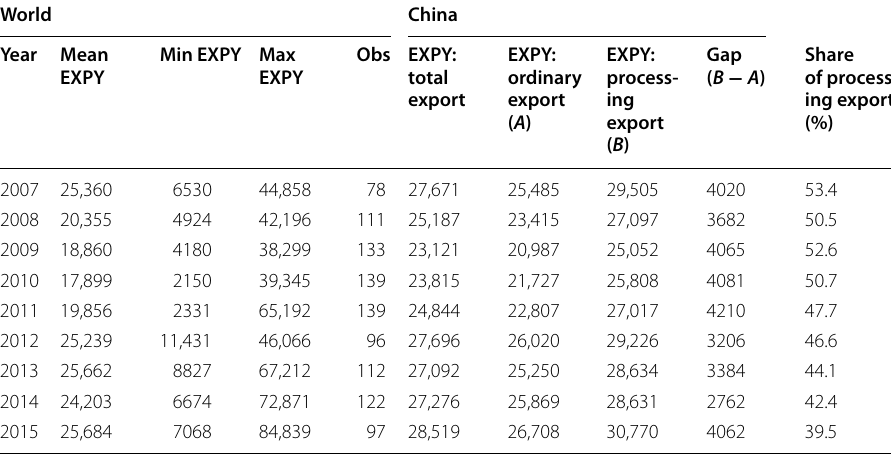
Table 2 Descriptive statistics of EXPY. Source : Author’s calculation